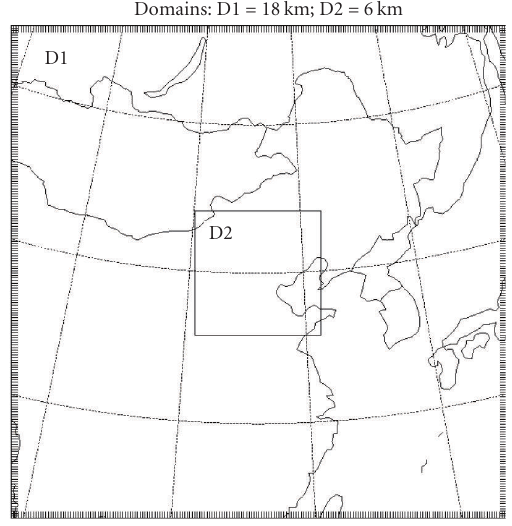
Figure 6: The domain size and location of the study. D1 resolution is 18 km and D2 resolution is